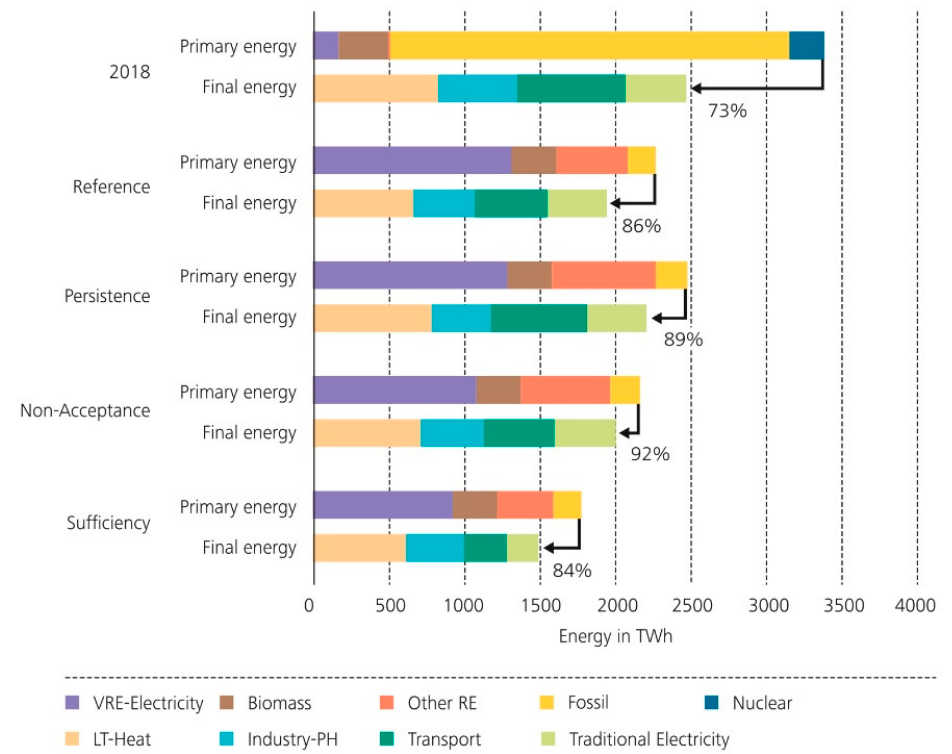
Figure 3. Primary energy and final energy in Germany for 2018 compared to four scenarios in 2050.